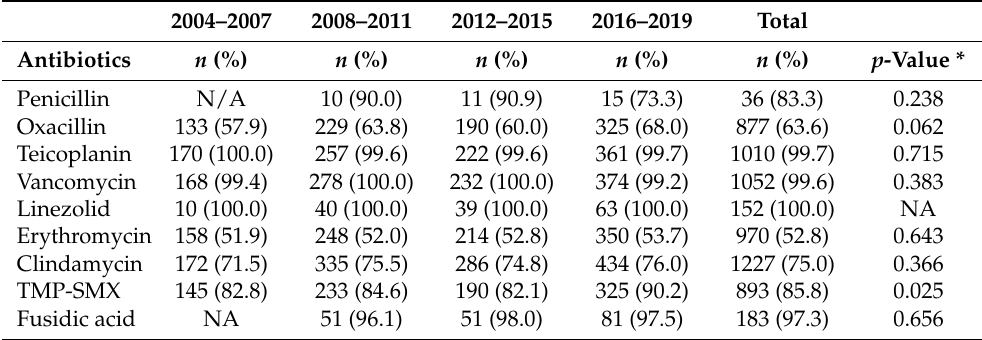
Table 6. Summary of in vitro antibiotic susceptibility of gram-positive isolates between 2004–2007,